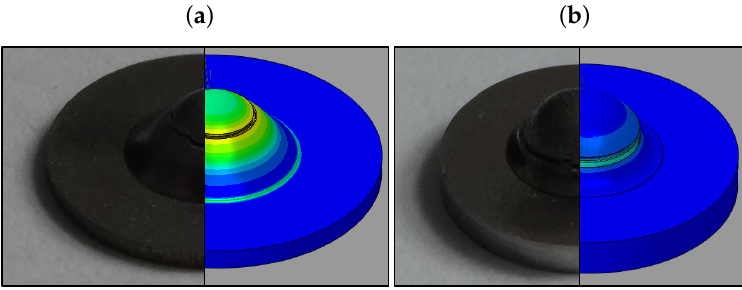
Figure 14. Circular crack path of disks with thicknesses of ( a ) 0.5 mm ( b ) 1 mm: optical images on the left and simulation on the